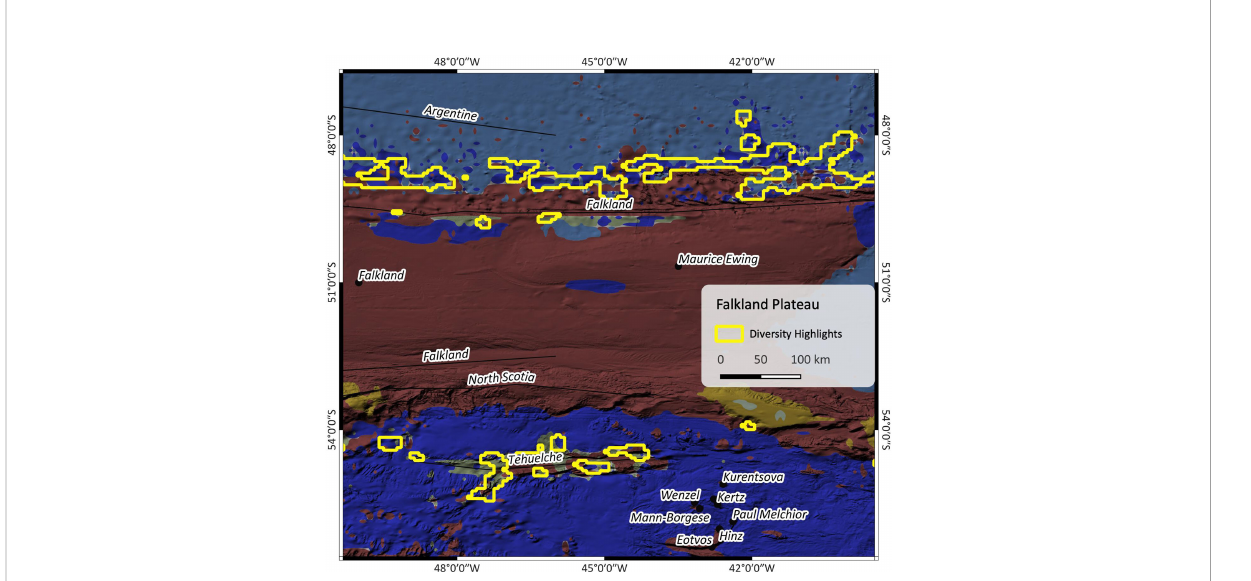
FIGURE 6 Patch richness at Falkland fracture Zone. The outlines are the highlighted regions as found by the patch richness analysis. For SBA color legend, please refer to Figure